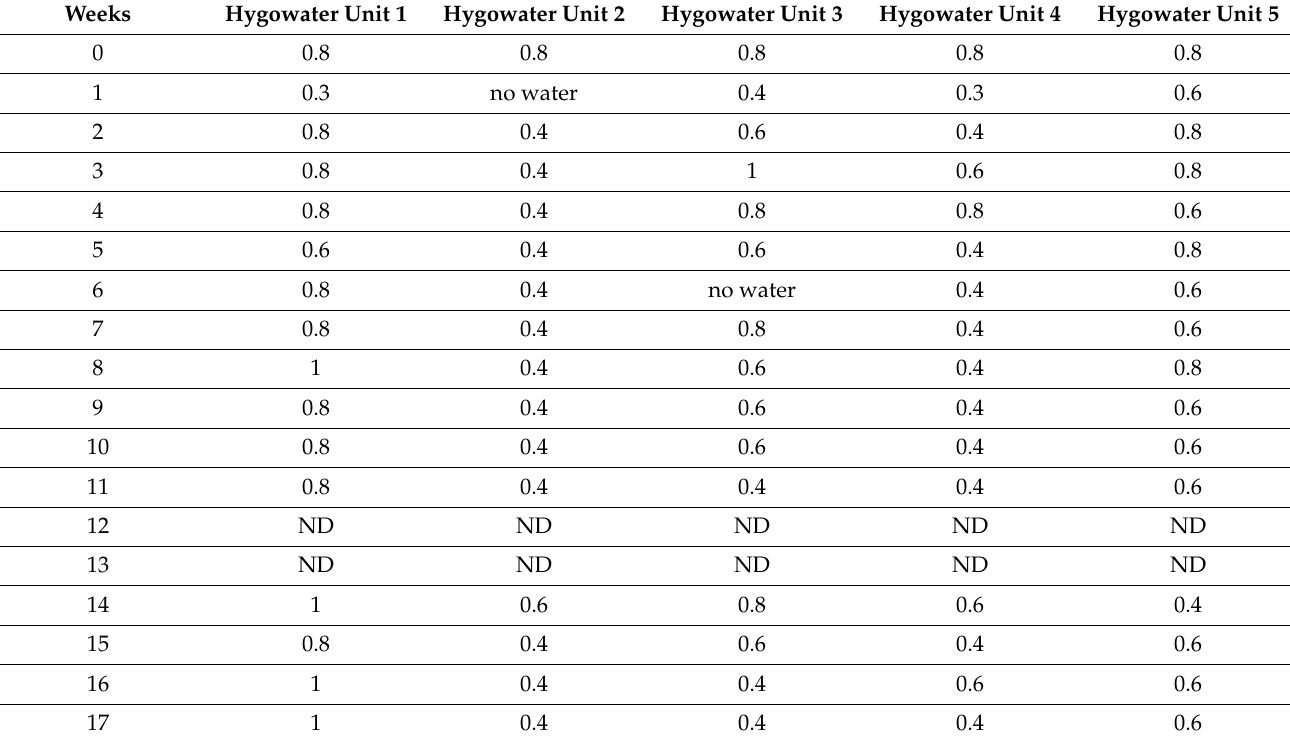
Table 3. Chlorine concentration follow-up, in mg/L (ND: No